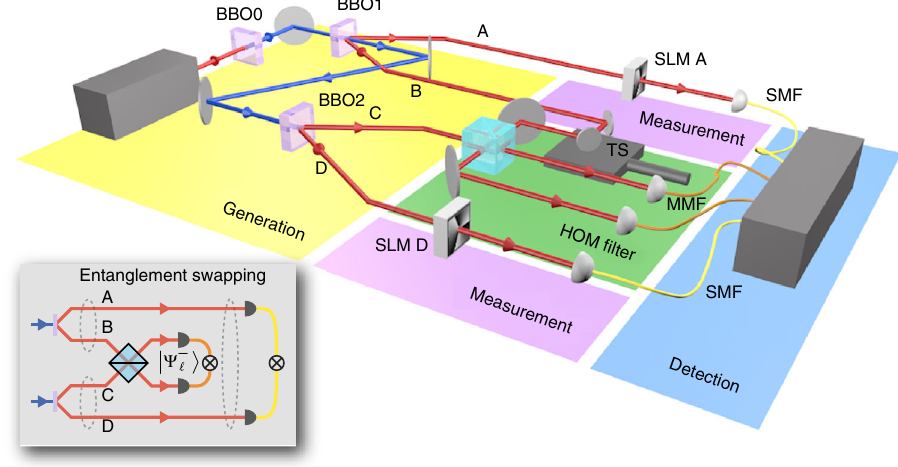
Fig. 1 A simpli fi ed version of the experimental setup. Generation: the fi rst β -barium borate crystal (BBO0) is pumped by a Ti:Sapphire laser to produce UV light via upconversion. BBO1 produces a downconverted pair A and B; BBO2 produces a downconverted pair C and D. Each is entangled in the state Ψ þ j i . Hong – Ou – Mandel (HOM) fi lter: the path length of B is adjusted using a translation stage (TS) such that B and C interfere on a beamsplitter; they are projected onto the antisymmetric state when detected in coincidence in the multi-mode fi bres (MMFs). Measurement: at this point, photons at A and D become entangled, which we measure using spatial light modulators (SLMs) in combination with single-mode fi bres (SMFs). Detection: each photon is detected using a single-photon avalanche detector, and coincidences are determined using a four-way coincidence detection system. Inset : a conceptual diagram of entanglement swapping. Entanglement between A and B is transferred to A and D via interference at a beamsplitter and detection in photons in AD, the state of photons A and D is determined using projective measurements with a combination of spatial light modulators (SLMs) and single-mode fi bres (SMFs). We perform tomography on the state of photons A and D to determine the degree of entanglement (Fig. 1). See ‘ Methods ’ for further experimental details.